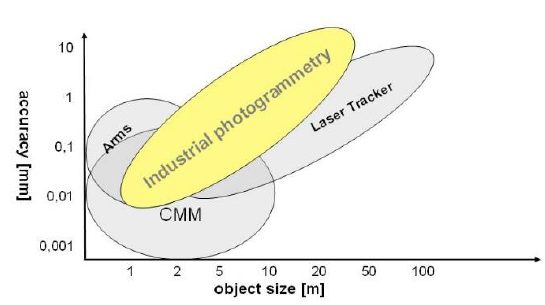
Figure 2: Measurement systems with relation to size and accuracy